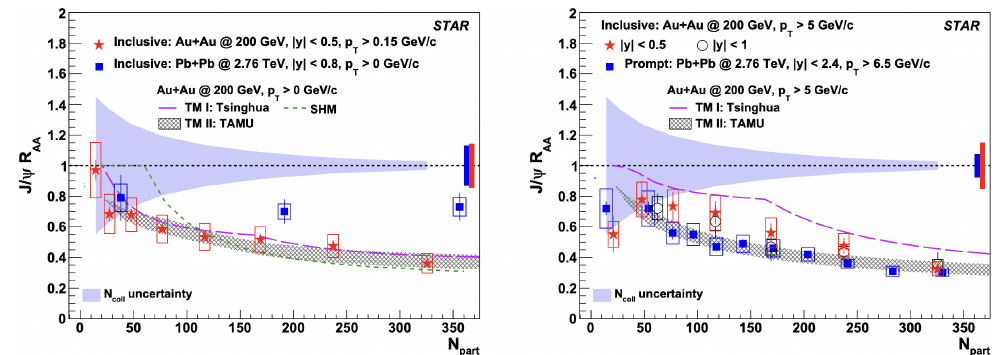
Figure 8. The J / ψ nuclear modification in A + A collisions as a function of N part , where the red (blue) data points represent the STAR (ALICE) measurements [52]. The data are compared with different theoretical models described in the text. Reprinted with permission from